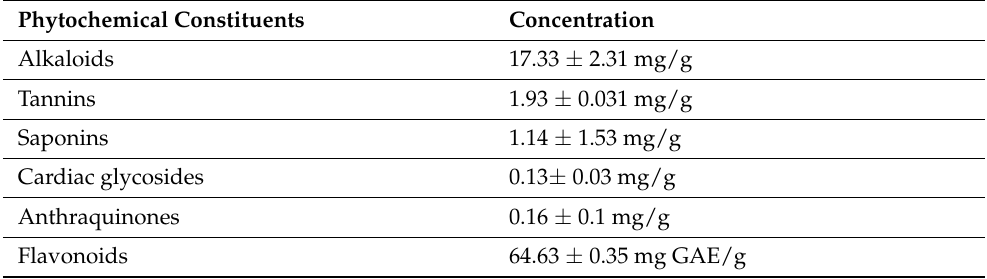
Table 1. Estimation of phytochemical content in HESAB.